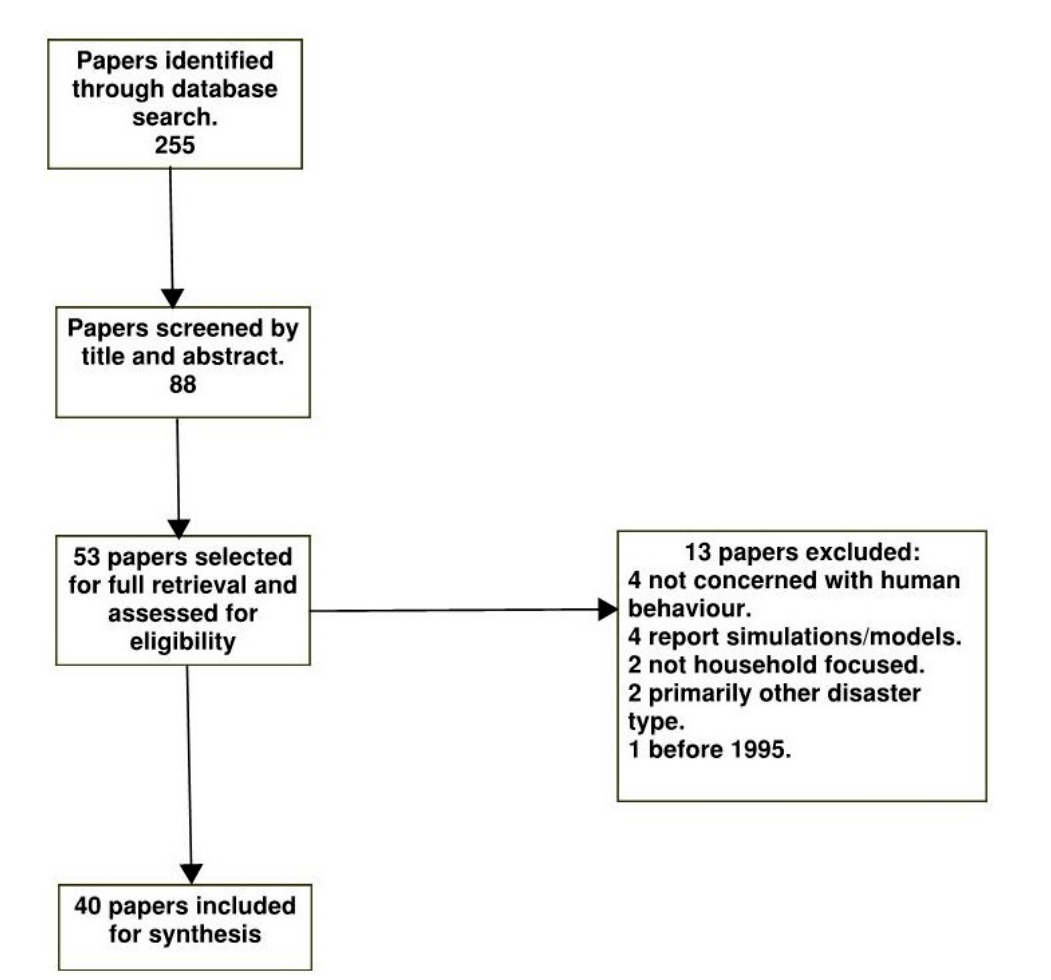
Figure 1. Flow chart showing details of literature search.